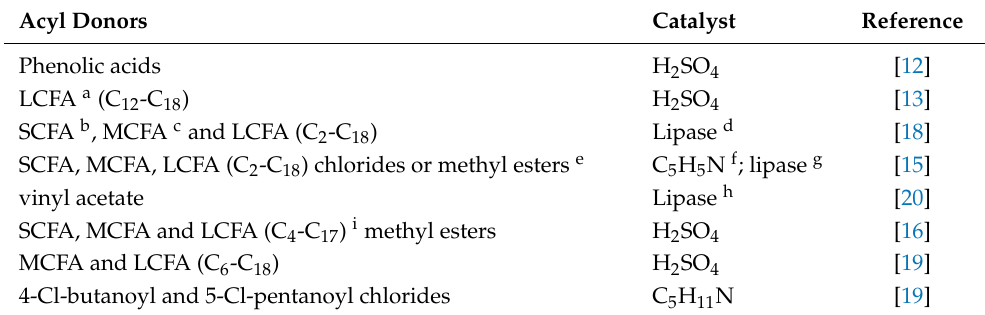
Table 1. Acyl donors and catalysts employed in the syntheses of 6- O -ascorbyl